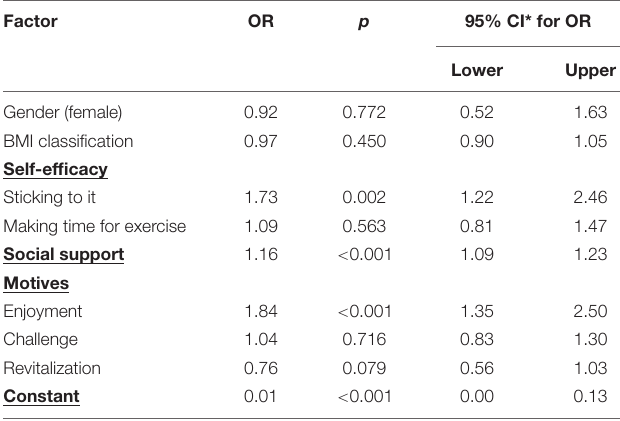
TABLE 3 | Mixed Effects Logistic Regression and Odds Ratio (OR) for reporting regular exercise attendance ( n = 228). Factor OR